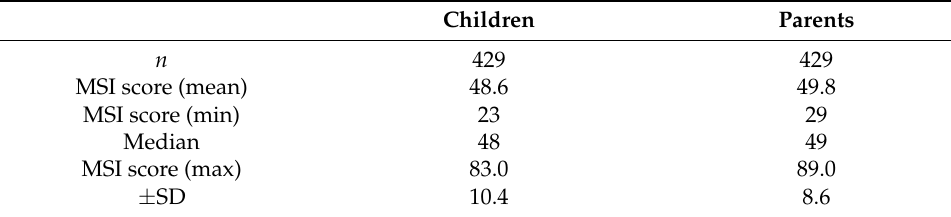
Table 2. Mean values of the MSI scores of the children and parents from Group A.